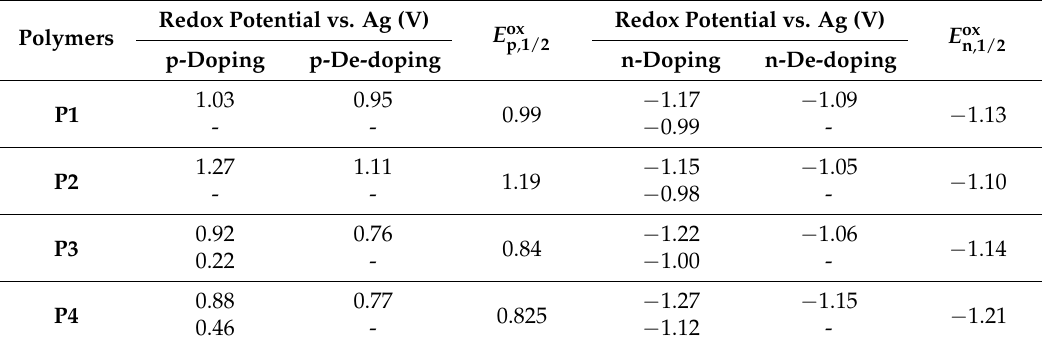
Table 1. CV data of the polymers.